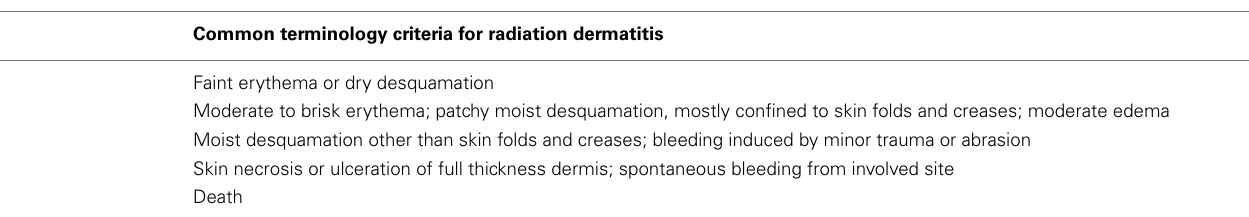
Table 2 | Scoring for acute and late